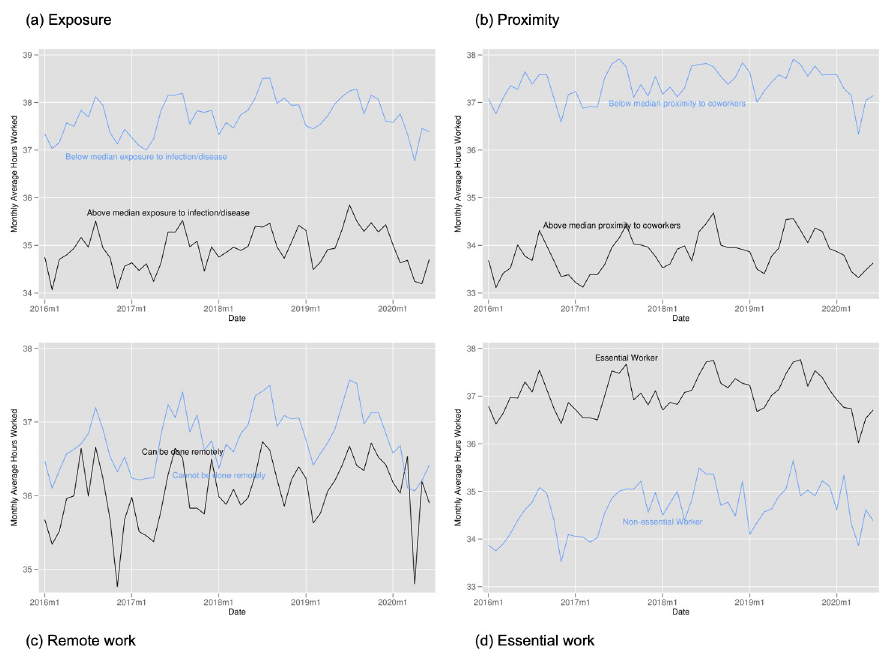
Fig 10. Hours worked by exposure to disease, proximity to coworkers, remote work, and essential work. Notes: Authors’ calculations. Data from the Current Population Survey. The time period is January 2016 to June 2020. Each panel plots the average weekly hours worked. Panel A for individuals in occupations above and below the median for our index of exposure to the disease. Panel B for individuals in occupations above and below the median for our index of proximity to coworkers. Panel C for individuals in occupations designated by [1] as being able to be done remotely. Panel D for individuals in occupations designated as essential and non-essential by the Labor Market Information Institute. Hours worked: civilians aged 16–70 who are employed and either at work or absent from work during the survey week, all jobs. Trimmed to exclude values below 1st percentile and above 99th percentile.